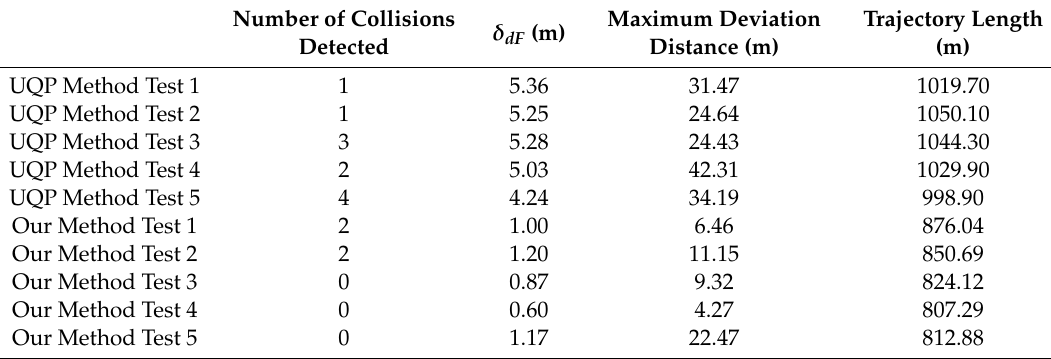
Table 2. Data comparison of five test results for each of the two methods.